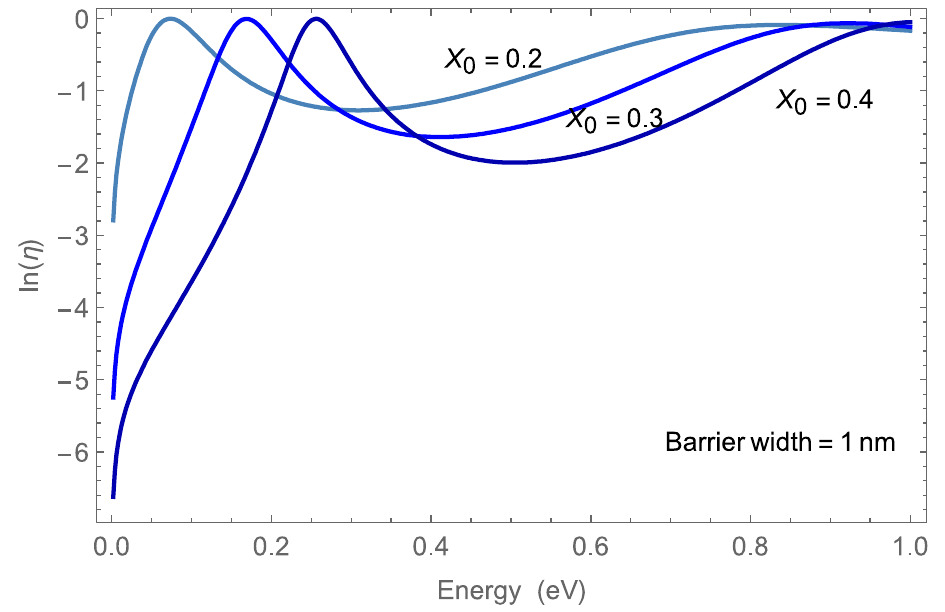
Figure 6. Logarithm of the transmission coefficient for electrons as a function of energy for the double-barrier In x Ga 1 − x N/GaN parabolic quantum well structure with various x 0 at an applied bias of 0.8 V, and barrier width 1 nm.